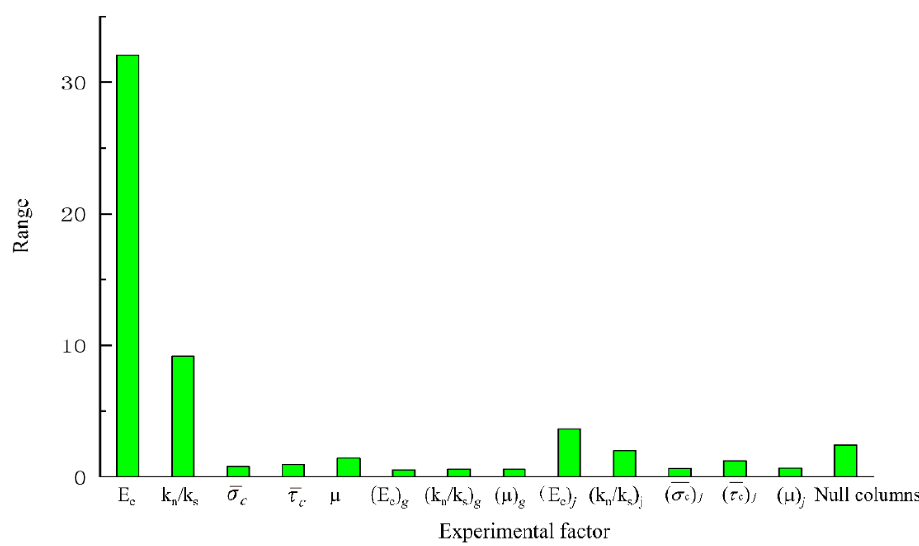
Figure 8. Results of analysis of range of peak intensity.